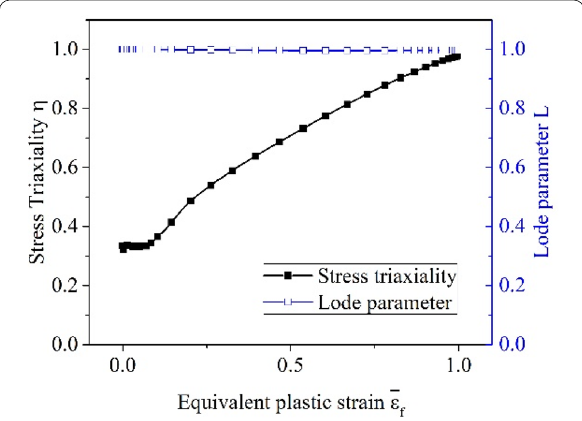
Figure 10 Evolution of ST and LP during the tension